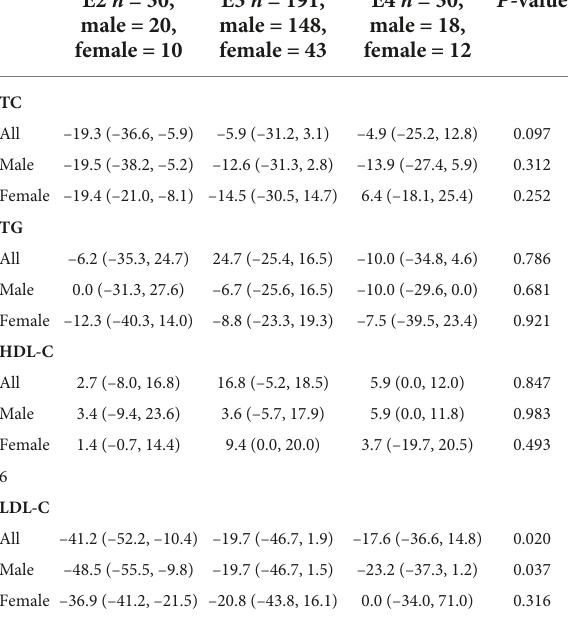
TABLE 3 Percentage variation in lipid concentrations after treatment with atorvastatin and stratified analyses according to gender.